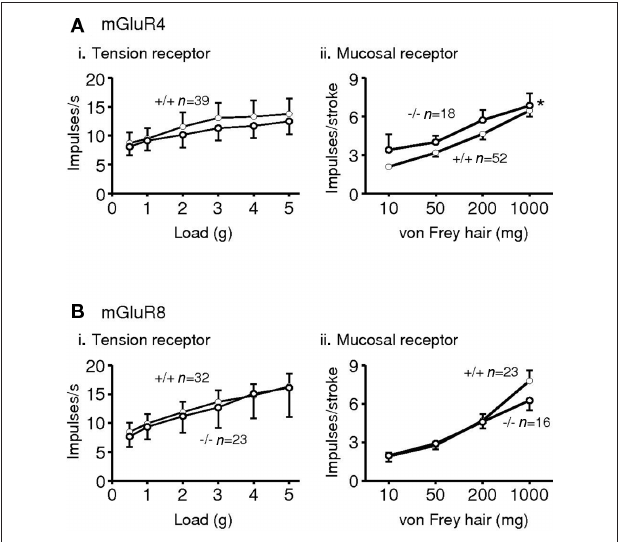
Figure 2 | responses of gastro-esophageal vagal afferents to mechanical stimulation in mice deficient in mglur4 (A*) or mglur8 (B). (i) The effects of disrupting mGluR on the responses to circumferential tension (average impulses s − 1 over stimulus duration of 1 min) of tension receptors. (ii) The effects of disrupting mGluR on the responses to mucosal stroking (impulses per stroke, mean of eight strokes) of mucosal receptors. The graphs show the mean ± SEM. Significant differences between mGluR + / + (•) and − / − ( ° ) mice (assessed using two-way ANOVA) is indicated adjacent to the response curves (* p < 0.05). n = number of afferents recorded. *Previously presented. The metabotropic glutamate receptor mGluR4 is required for normal visceral mechanotransduction (Page et al.,